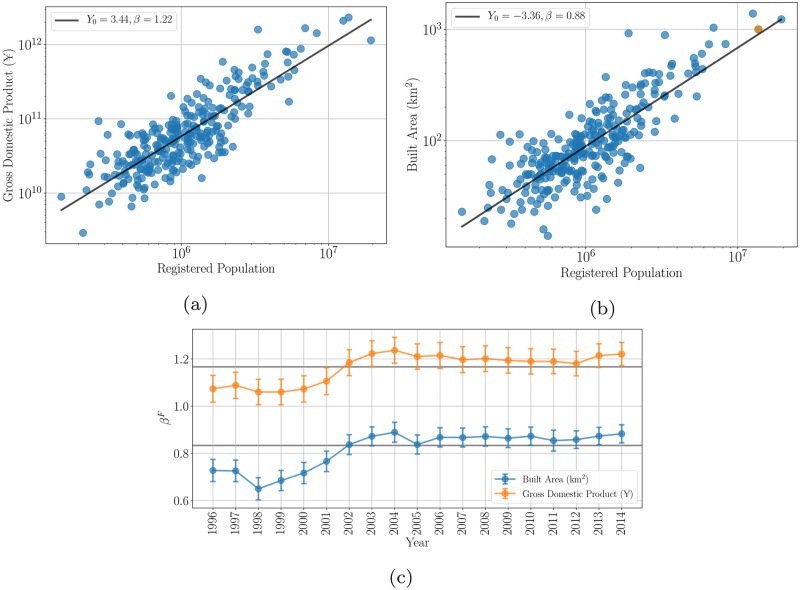
Scaling relations and exponents for Chinese prefecture-level cities.The superlinear scaling law for the Gross Domestic Product vs. size by population in 2014 (a). The exponent β is 1.22 (95% CI [1.171 1.269]). The sublinear scaling law for the built up surface vs. size by population in 2014 (b), with an exponent β of 0.88 (95% CI [0.842 0.918]). No data for Shanghai is provided for 2014, the orange symbol is the built up surface of Shanghai in 2013. Temporal evolution of the exponents for GDP and built area with the respective 95% CIs (c). The two gray lines depict the simplest expectation for the theoretical exponents at 7/6 and 5/6, respectively. These exponents clearly show increasing returns to scale in economic performance and economies of scale in land use.